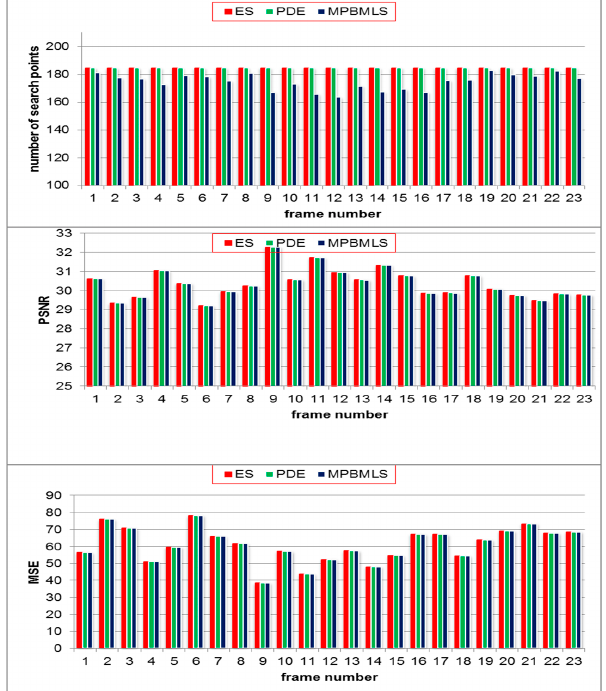
Figure 7. Average number of search points per MB, PSNR performance, and MSE of MPBMLS, FS, and PDE in the “Carphone” video sequence over 23 frames.